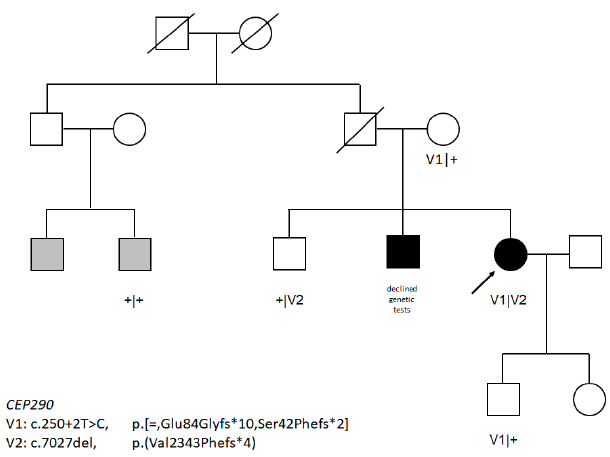
Figure 1. Pedigree of the family of a ff ected proband (marked with an arrow). Variants are marked with V; + represents wild type allele.